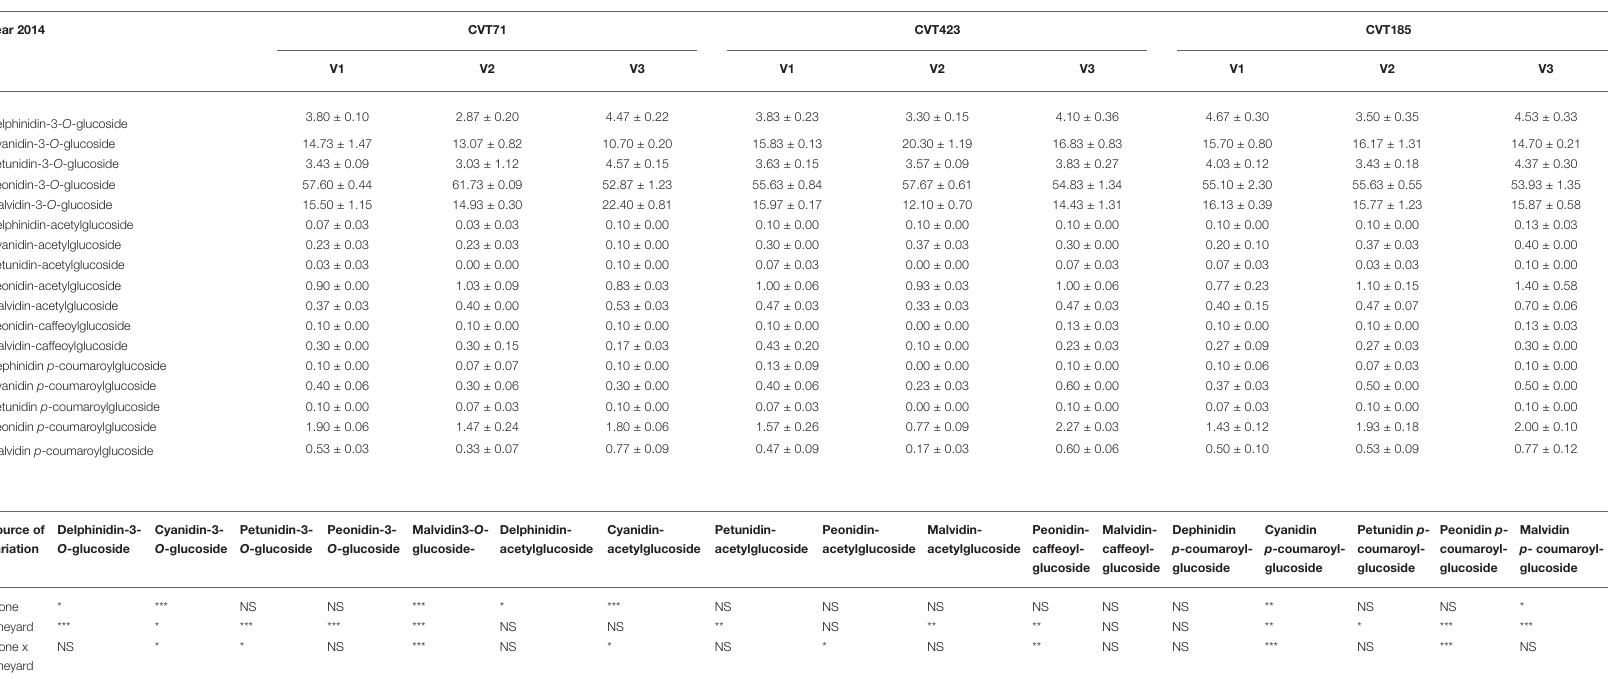
TABlE 4 | Anthocyanin profiles (percent) in the skin of grapes collected at 24°BRIX from the studied “Nebbiolo” clones (CVT71, CVT423 and CVT185) in three different vineyards of the Langhe area (V1, V2, V3) in 2014. Data are means ± standard error ( n = 21 ). Results of the ANOVA analysis are reported below the